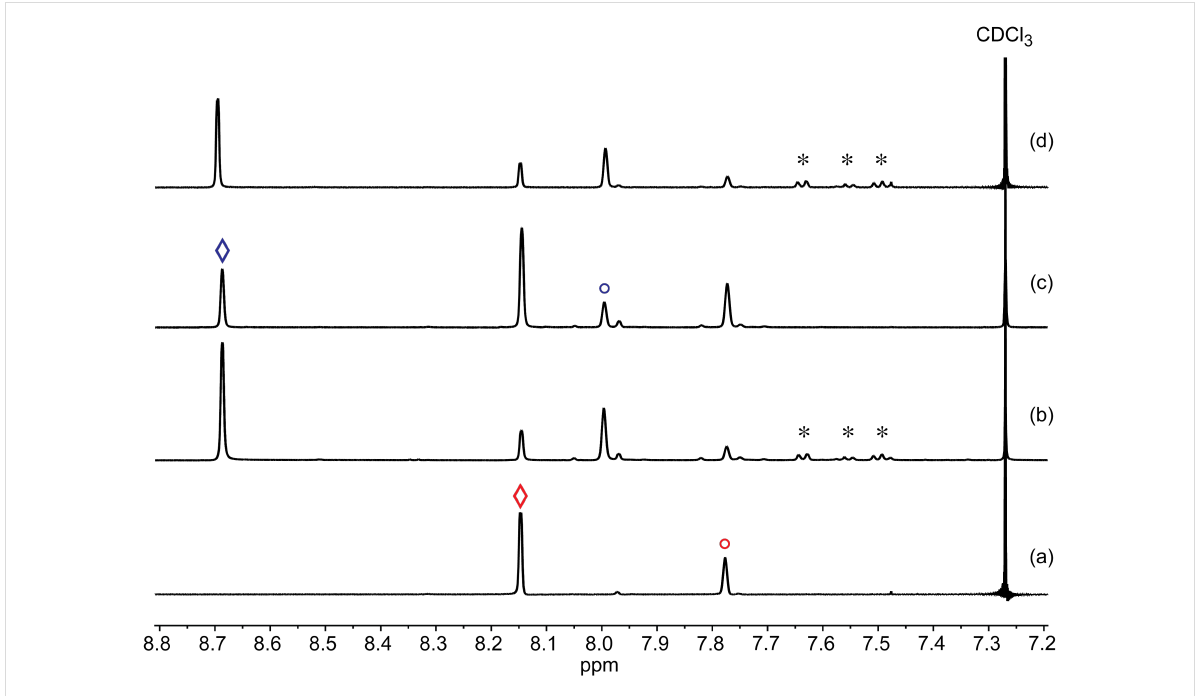
Figure 1: Partial 1 H NMR spectra (sp 2 CH, 500 MHz, CDCl 3 ) relating to the reaction of 1,3,5-(R f6 ) 2 C 6 H 3 I and Cl 2 in CF 3 C 6 H 5 at − 30 to − 35 °C: (a) starting 1,3,5-(R f6 ) 2 C 6 H 3 I; (b) aliquot taken after 24 h and removing nearly all CF 3 C 6 H 5 (* = residual signals) by rotary evaporation (75:25 ArICl 2 / ArI); (c) aliquot taken after 24 h and removing all solvents by oil pump vacuum at − 40 °C (35:65 ArICl 2 /ArI); (d) the sample from b, which was